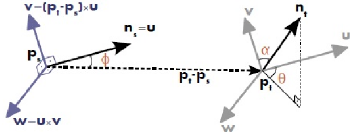
Figure 8: Darboux frame between a point pair